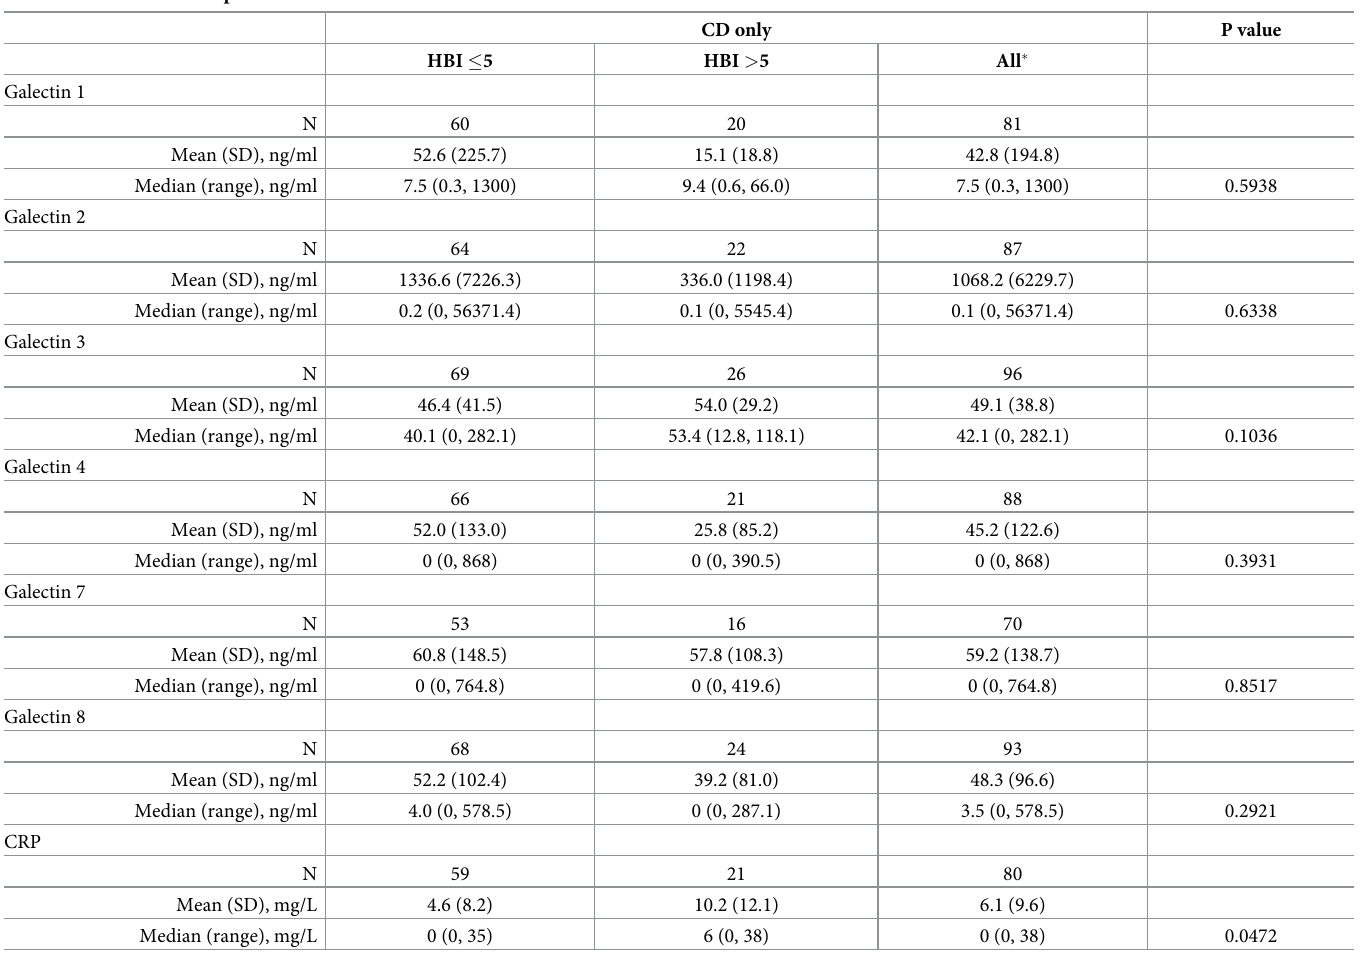
Table 4. Galectin levels in patients with active and inactive